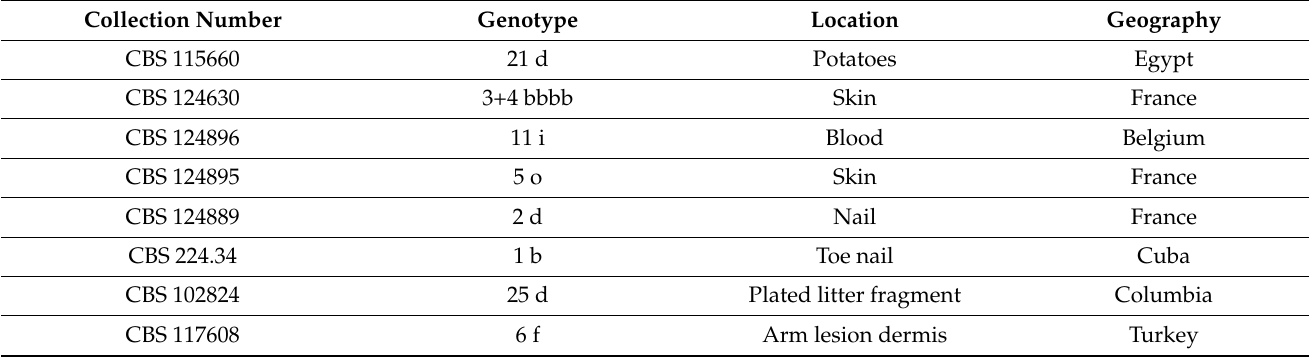
Table 2. Genotype and origin of the strains of the Fusarium solani species complex used.